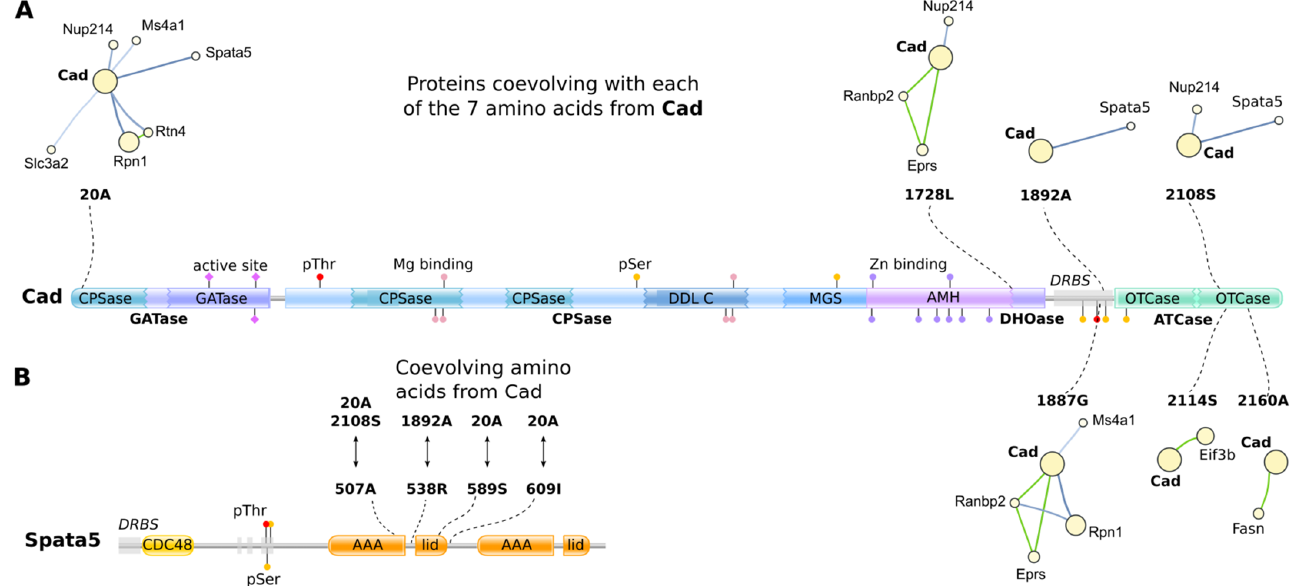
Figure 5. Suggested interactions between Cad and the proteins predicted to coevolve with it. ( A ) Coevolving sites from Cad. The coevolving amino acid residues are indicated by dashed lines and plotted onto the protein topology. Proteins coevolving with each site are shown as mini-clusters. Protein regions are indicated in bold next to the scheme: GATase (glutamine amidotransferase), DHOase (dihydroorotase), DRBS (disordered region binding sites), and ATCase (aspartate transcarbamylase); domains are indicated within scheme: CPSase (Carbamoyl Phosphate Synthase small chain), DDL (D-alanine-D-alanine ligase), MGS (methylglyoxal synthase), AMH (amidohydrolase family domain), and OTCase (ornithine carbamoyltransferase, carbamoyl-P binding domain); active sites, phosphorylation sites (Ser, Thr) and metal-binding sites (Mn, Zn) are indicated as lollipops. ( B ) The amino acid residues from Spata5 predicted to coevolve with Cad. The amino acids are plotted onto the protein topology and the paired sites from Cad are indicated. Domains: CDC48 (cell division protein 48), AAA (ATPases associated with a variety of cellular activities), and lid (AAA+ lid domain).